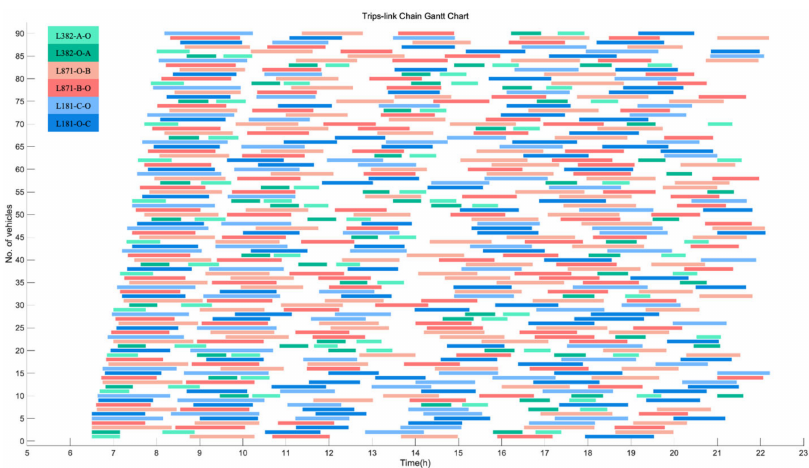
Figure 16. The Gantt diagram from of